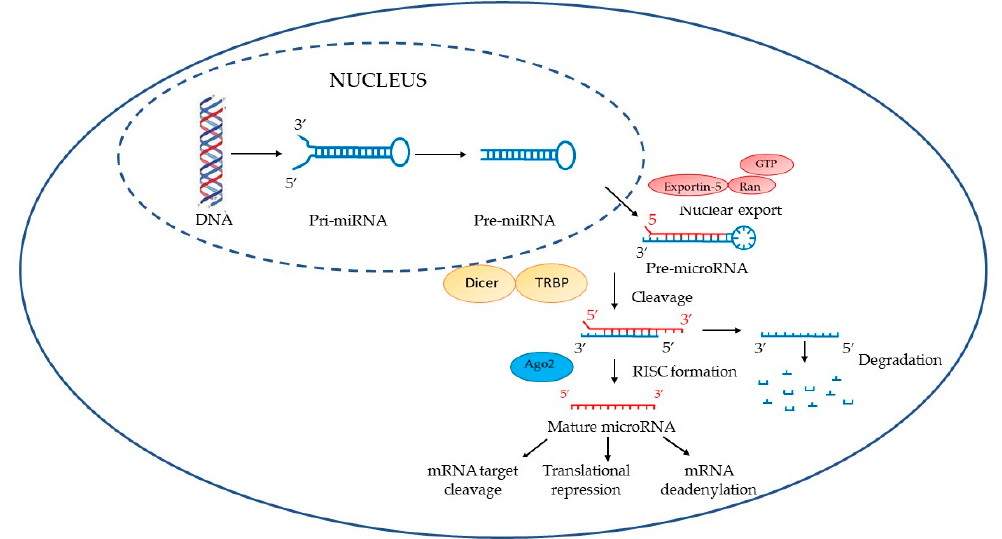
Figure 1. Biogenesis of miRNA. Adapted from Winter et al., 2009 [30] and Vrijens et al., 2015